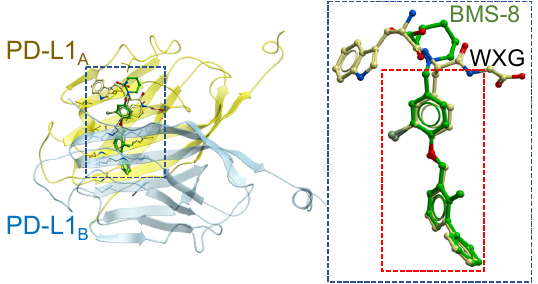
Figure 5 . Root mean square deviation (RMSD) calculation between amino-X and BMS-8 bound to PD-L1 AB homodimer. After docking of amino-X (in this case, WXG), we calculated RMSD between a part of WXG (excluding C α , amino-group and carboxyl-group) and the corresponding part of BMS-8 , as shown by the red dotted-rectangle.